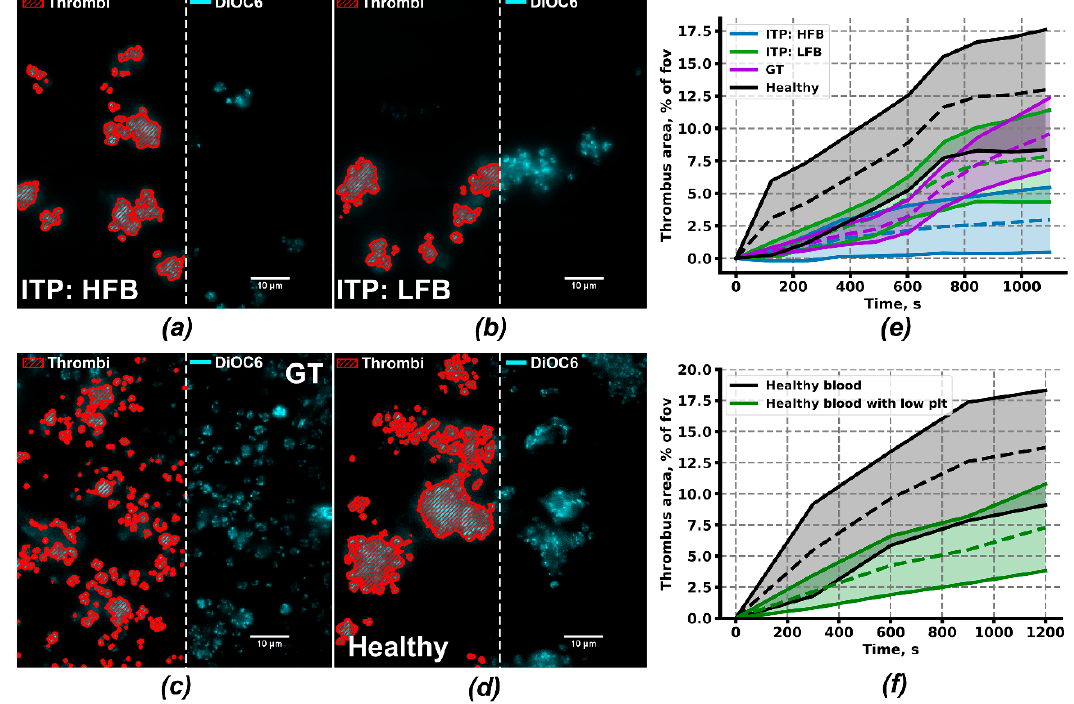
Figure 4. Ex vivo thrombus growth under low shear rate conditions. ( a − d ) Typical thrombi on fibrillary collagen of ITP:HFB ( n = 3, a ), ITP:LFB ( n = 3, b ), GT ( n = 4, c ) and healthy donors ( n = 7, d ) after 15 min of hirudinated whole blood perfusion. Method of thrombi area calculation is demonstrated by red dashed areas on the left halves of the panels. ( e ) Mean thrombus area (dashed lines) ± SD (solid lines) of ITP:HFB (blue), ITP:LFB (green), GT (purple) and healthy donors (black). ( f ) Mean thrombus area (dashed lines) ± SD (solid lines) of healthy donors (black) and healthy donors with 5-times reduced platelet count (green).